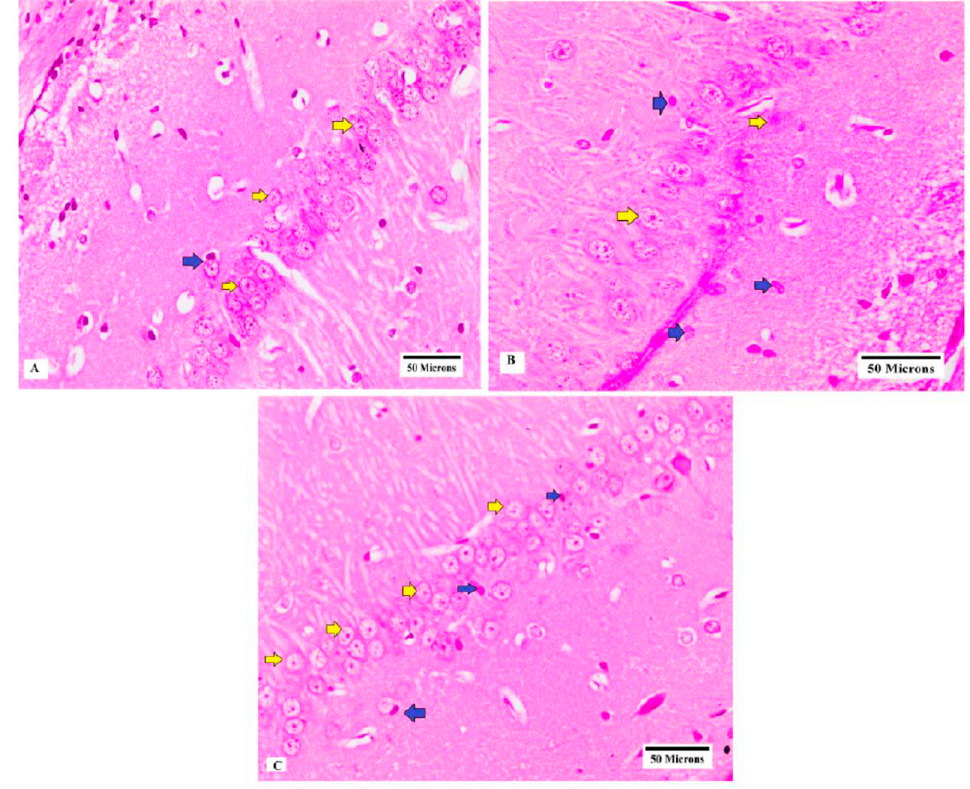
Figure 4. Brain specimens of CA3 hippocampal region showing ( A ) large number of neurons with normal shapes (yellow arrows) (normal group), ( B ) low number of neurons with normal shapes (yellow arrows) and large number of neurons with pyknotic changes and dead neurons (blue arrows) (PTZ group) and ( C ) large number of normal neurons (yellow arrows) with minimal pyknotic changes (blue arrows) (GLP1 + PTZ group) (H & E, 400×).